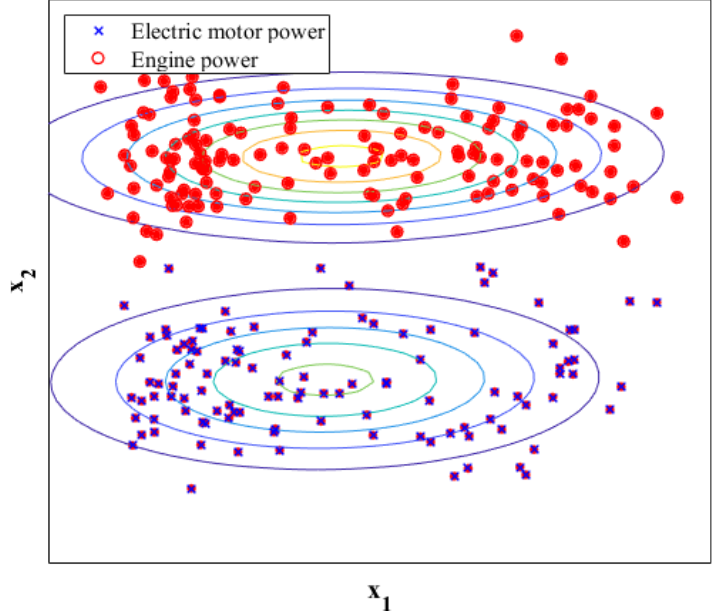
Figure 10. GMM classification of electric motor and engine power.